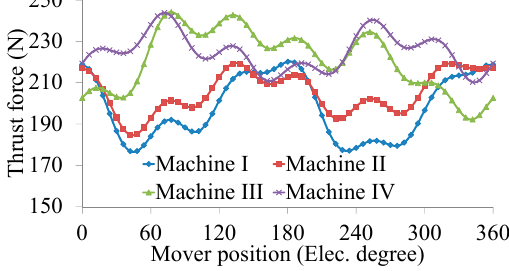
Figure 16. Thrust force comparison among four machines.